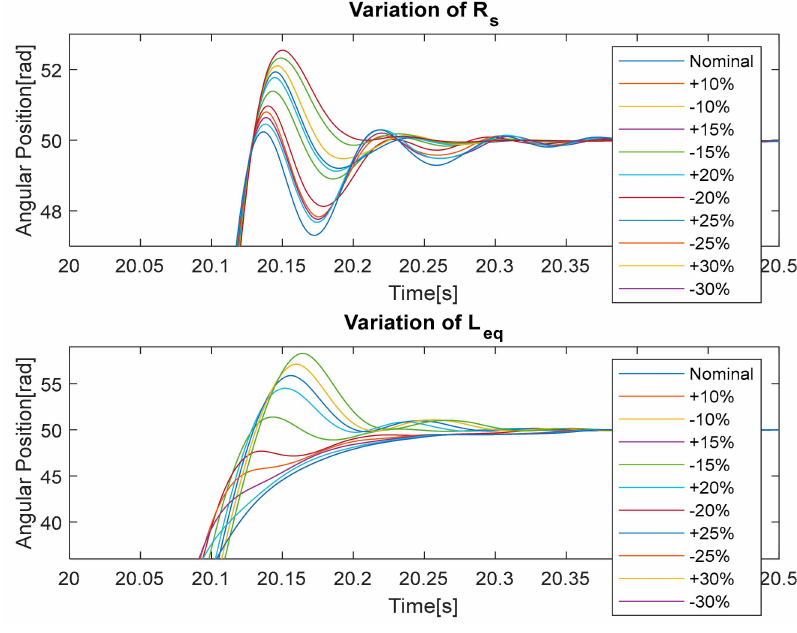
Figure 12. Robustness analysis in terms of variation of the parameters R s and L eq .